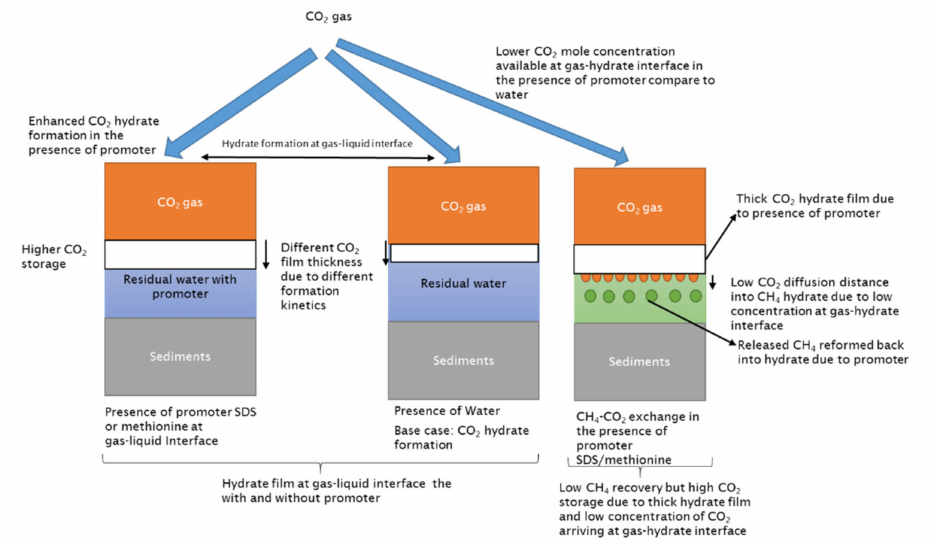
Figure 11. CH 4 -CO 2 exchange mechanism in the presence of promoter and water and their interconnection. Promoter increases CO 2 storage but also reduces CH 4 recovery due to thin CO 2 hydrate barrier and CH 4